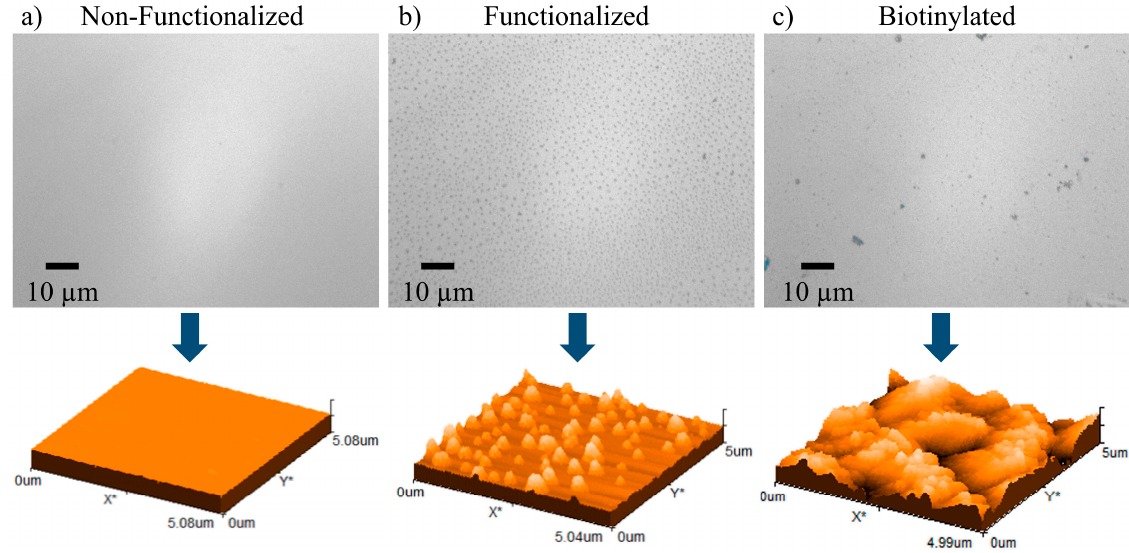
Figure 2. Optical microscopy ( top ) and AFM ( bottom ) images of the: ( a ) bare Si 3 N 4 surface, ( b ) after APTES-GTA deposition, and ( c ) after biotin